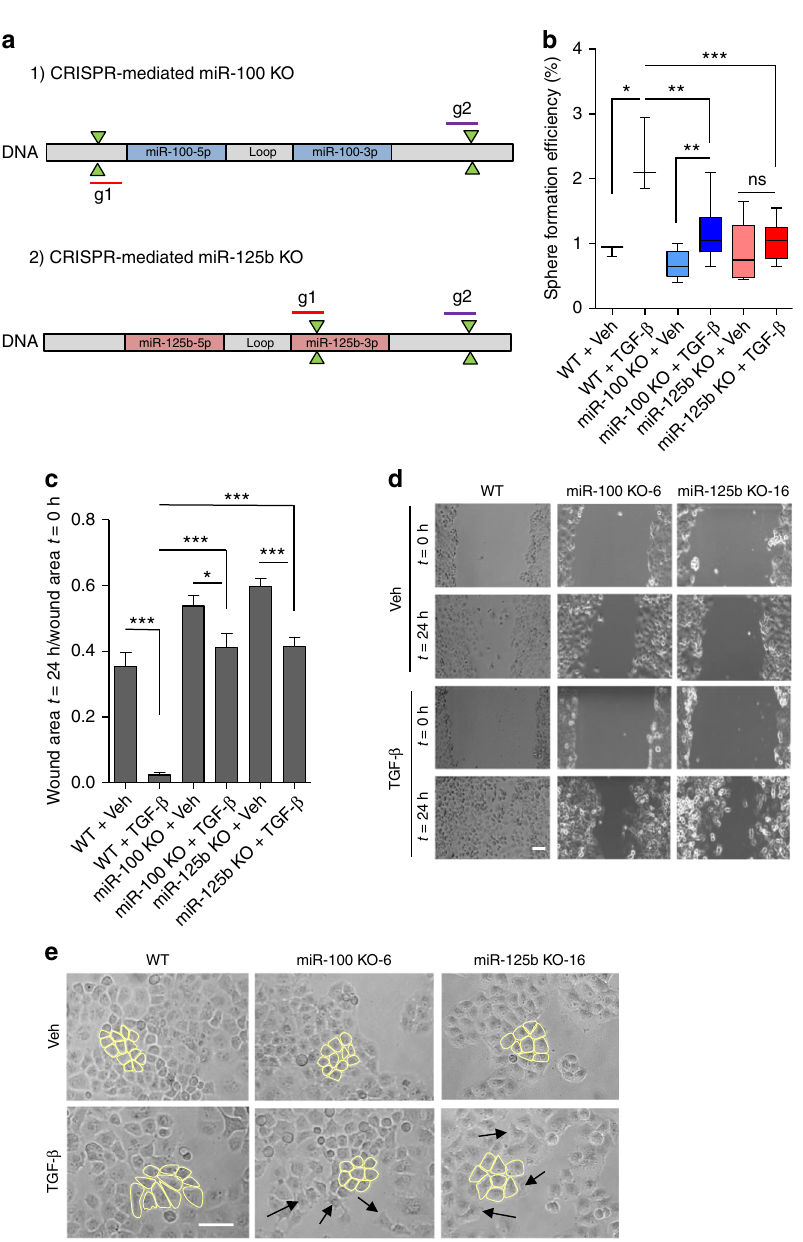
Fig. 4 miR-100 and miR-125b impairs TGF- β -induced EMT, and stemness. a Strategy used to generate CRISPR-Cas9 mediated KO of miR-100 (top) and miR-125b (bottom) in PANC-1 cells. Schematic structure of both miRNA loci are shown. Pairs of sgRNAs were used and are indicated as g1 and g2. b Sphere-forming assay in PANC-1 CRISPR-Cas9 KO clones for miR-100 ( n = 3) and miR-125b ( n = 3) and in parental wild-type cells (WT). Cells were treated with vehicle (Veh) or TGF- β for 72 h in adherent and then placed in non-adherent conditions for sphere assay. Box plots show median and whiskers are minimum and maximum. Results are from three independent experiments each performed in triplicate. c Wound-healing migration assay performed in PANC-1 CRISPR-Cas9 KO clones for miR-100 ( n = 3) and miR-125b ( n = 3) and WT cells treated with vehicle (Veh) or TGF- β for 72 h. The wound area at time 0 h and the area left unhealed at 24 h was measure using ImageJ software. The results are presented as a ratio (wound area t = 24 h / wound area t = 0). Results are shown as mean ± s.e.m. Data are from three independent experiments each performed in triplicate. d Representative pictures of the wound-healing assay. Clone 6 for miR-100 KO (KO-6) and clone 16 for miR-125b KO (KO-16) are shown here. Scale bar: 100 µ m. e PANC-1 WT cells CRISPR-Cas9 KO clones for miR-100 ( n = 3) and miR-125b ( n = 3) and WT cells treated with vehicle (veh) or TGF- β for 72 h. Representative phase- contrast images for miR-100 KO-6 and miR-125b-KO16 are shown here. Cell shape of representative cells was manually delineated. Arrows indicate occasional elongated cells in miR-100 and miR-125b KO lines treated with TGF- β . Scale bar: 100 µ m. * P -value < 0.05, ** P -value < 0.01, *** P -value < 0.001. P -values were calculated using two-tailed Student ’ s t